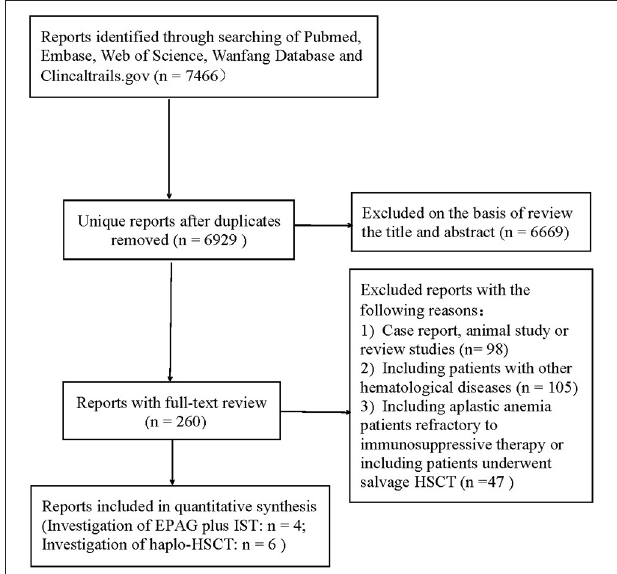
FIGURE 1 | Search flow diagram in our